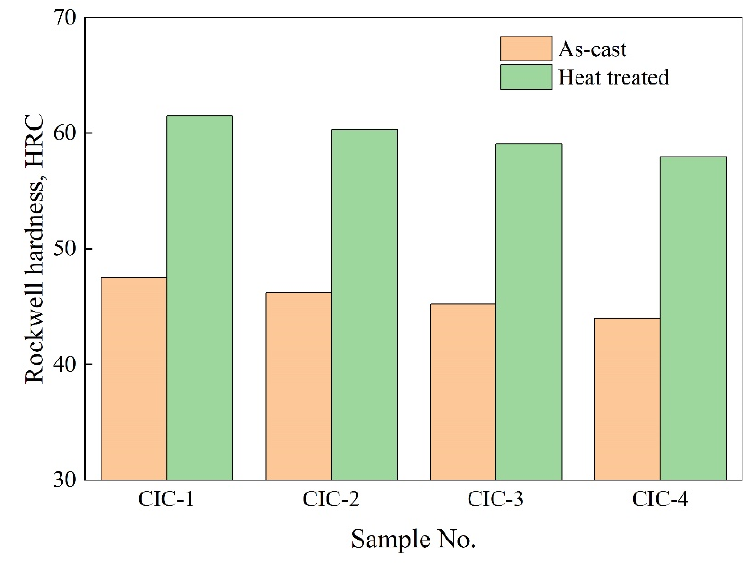
Figure 11. Rockwell hardnesses of the as ‐ cast and heat ‐ treated CICs.